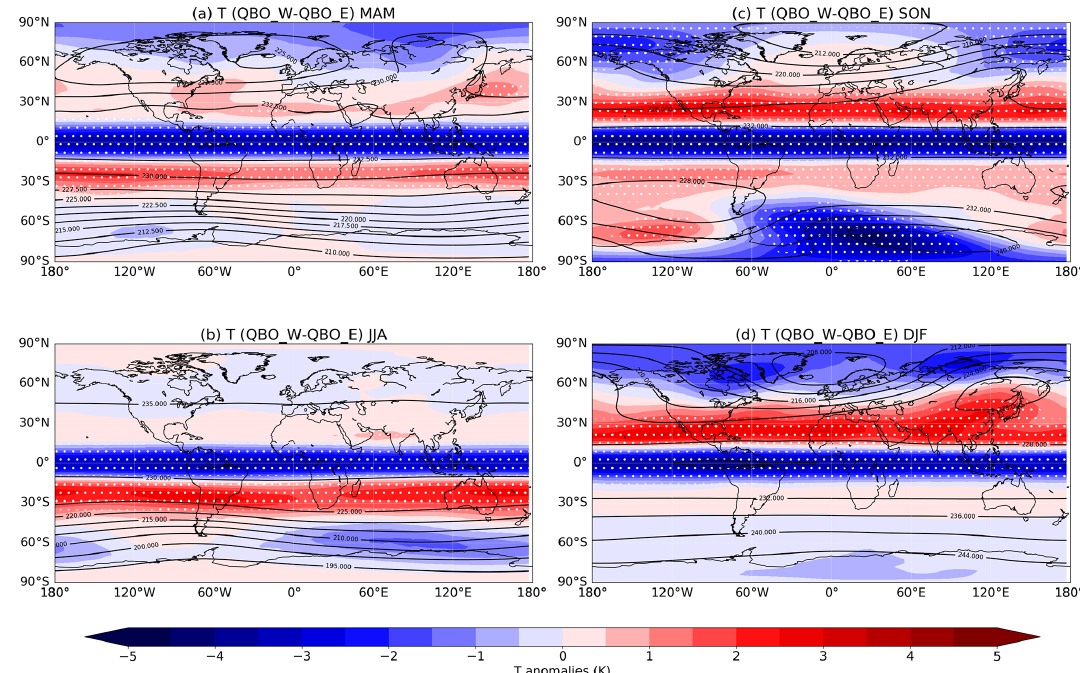
Figure 10. Influences of QBO (QBOW–QBOE) on global temperature ( T at 10hPa), based on ERA5 data for the period 1979–2020. The climatological values of temperature during QBOE in each season are also shown (contour lines, with contour intervals of 2, 5, 4, and 4K in panels (a) , (b) , (c) , and (d) , respectively). (a) MAM. (b) JJA. (c) SON. (d) DJF. Stippled areas indicate results that are statistically significant over the 95% level, using the two-tailed Student’s t